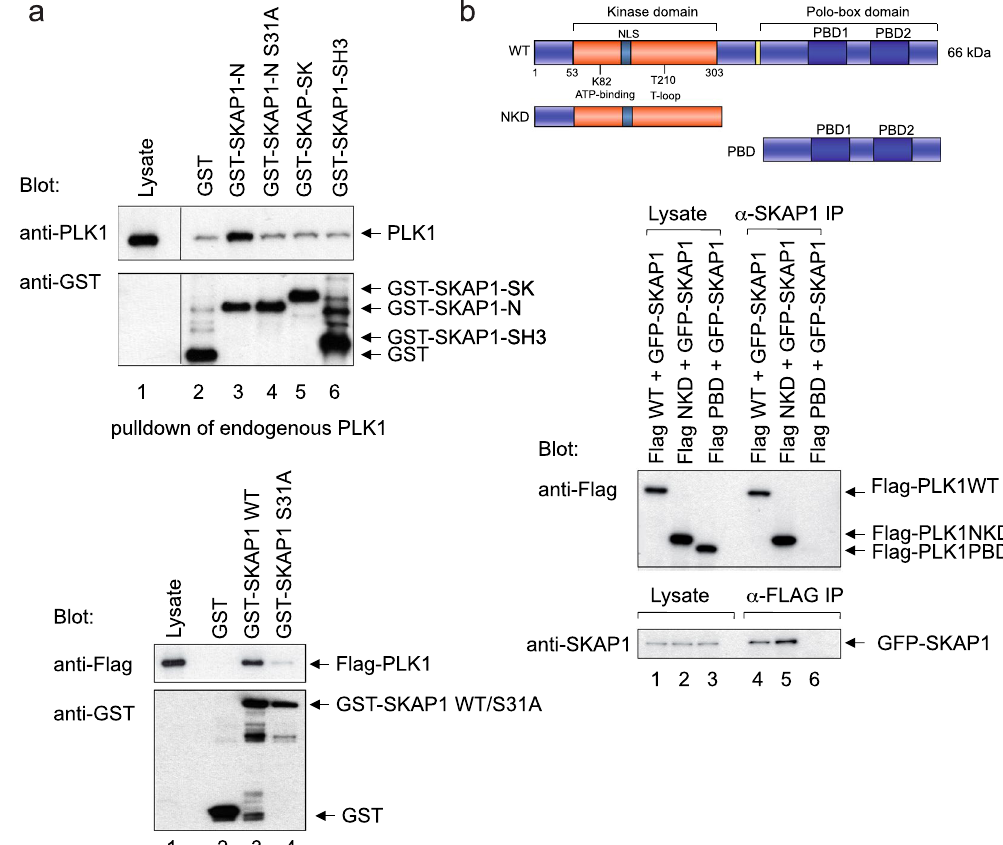
Figure 4. Binding sites between PLK1 and SKAP1. (Panel a) Upper panel::SKAP1 S31 in the N-terminal domain binds PLK1. GST fusion proteins of regions in SKAP1 were used to co-precipitate endogenous PLK1 from lysates of Hela cells. Mutation of S31A in this region disrupted the interaction. Lane 1: lysate; lane 2: GST; lane 3: GST-SKAP1-N; lanes 4: GST-SKAP1-S31A; lane 5: GST-SKAP1-SK; lane 6: GST-SKAP1-SH3. Lower panel: GST full-length proteins of SKAP1 WT and S31A mutant were used to co-precipitate Flag-PLK1 expressed in 293T cells. Lane 1: lysate; lane 2: GST; lane 3: GST-SKAP1 WT; lane 4: GST-SKAP1-S31A. GST- Blot shows equal expression. (Panel b) SKAP1 binds to the NKD kinase domain of PLK1. Co-expression in 293T cells of either Flag-tagged PLK1, N-terminus-kinase domain (NKD) or the PBD domains with GFP- SKAP1. Middle panel: GFP-SKAP1 readily co-precipitated wild type PLK1 (lane 4) and the NKD protein (lane 5), and not to the PBD domains (lane 6). Lower panel: Flag-PLK1 PBD failed to precipitate